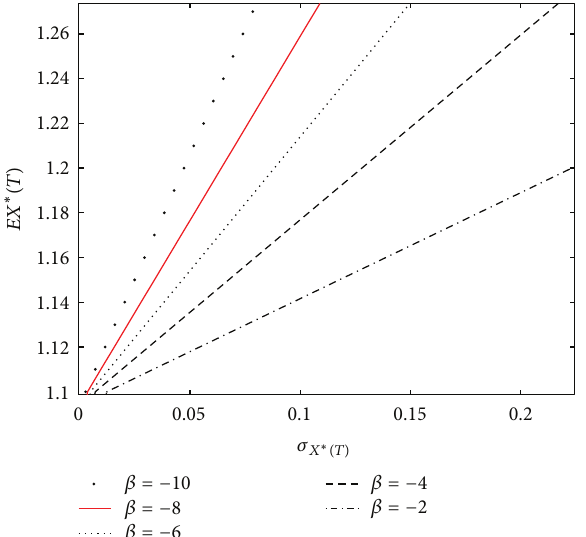
Figure 6: The efficient frontiers in mean-standard deviation plane ( 𝛽 = −1.0, . .. ,−0.2